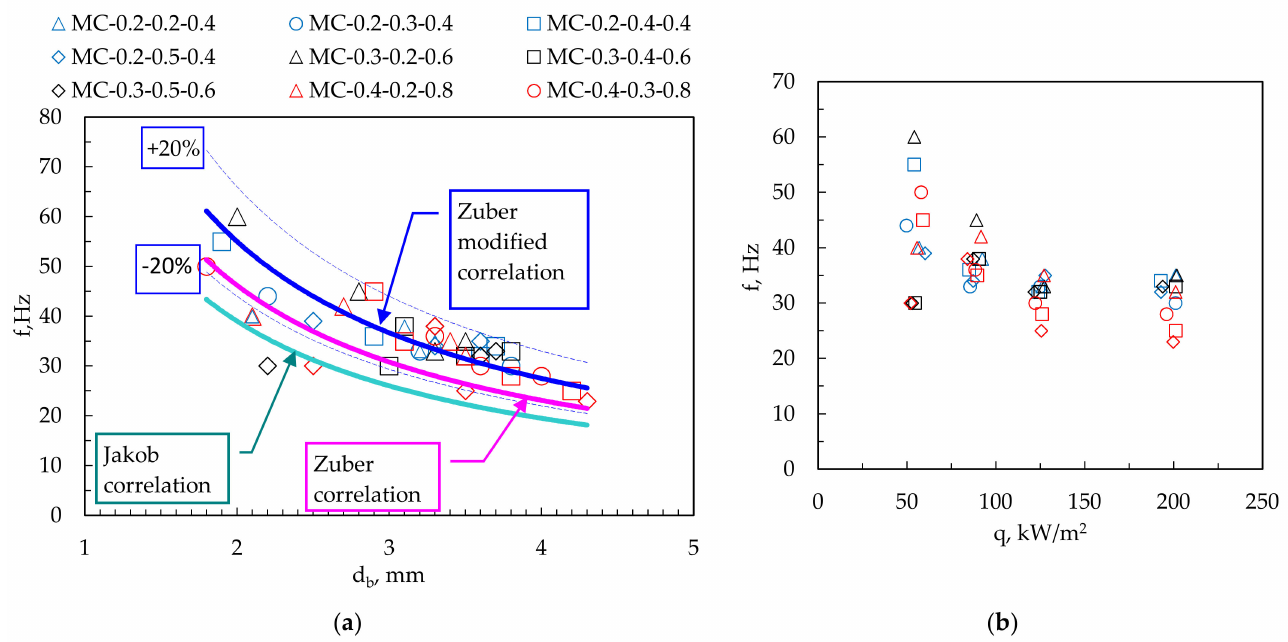
Figure 10. Averaged departing bubble frequency vs. departing bubble diameter ( a ) and heat flux ( b